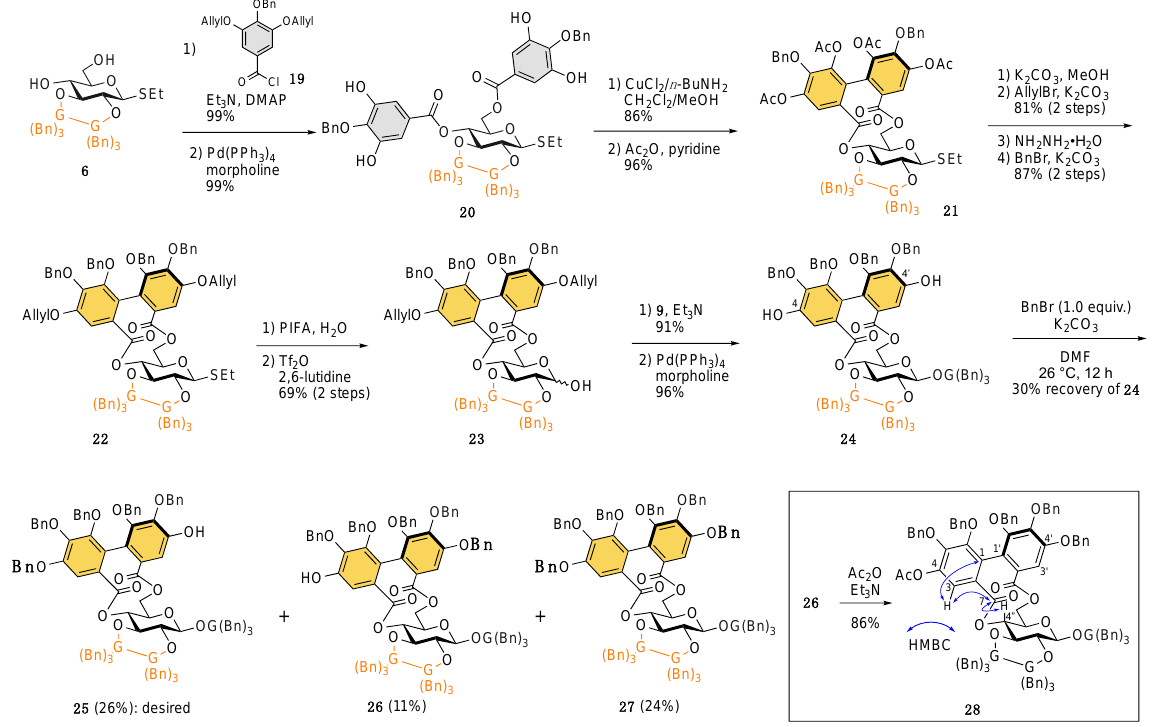
Scheme 3. Preparation of phenol 25 toward the synthesis of rugosin C ( 4 ). DMF: dimethylforma- mide.